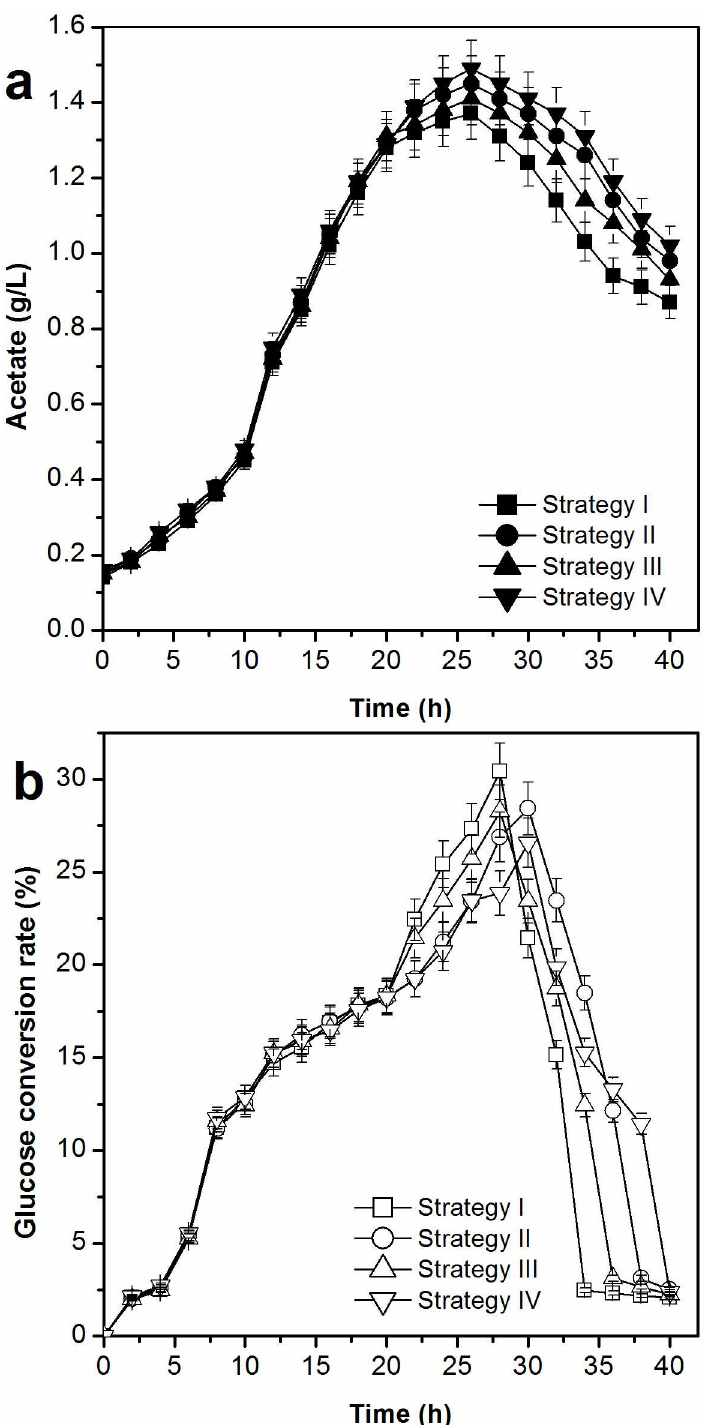
Fig 8. Effect of a cell recyclestrategy on accumulation of acetateand glucose conversion rate of L- tryptophan in L-tryptophan fermentation by TRTHBPA ( P < 0.05).